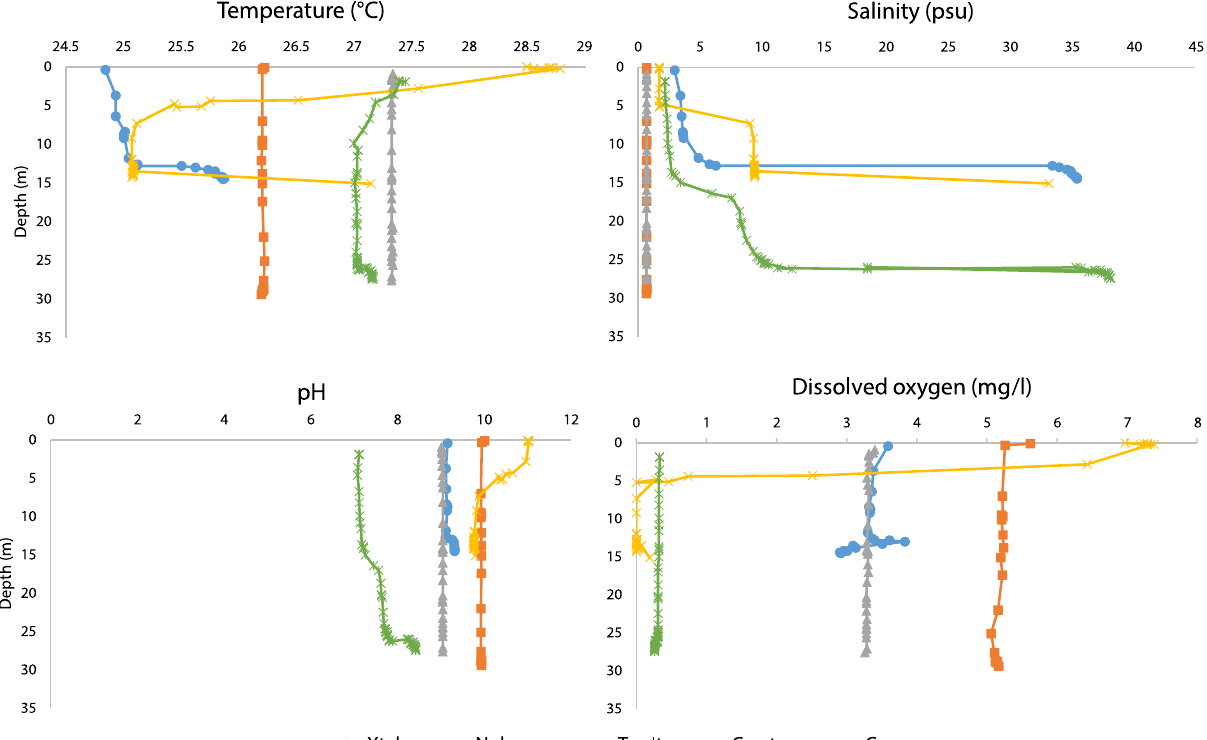
Figure 2. Vertical profile of physical and chemical hydrological parameters (Temperature, Salinity, pH and Dissolved Oxygen) of Cave Systems, Xtabay (blue), Nohmozon (orange), Tza Itza (grey), Crustacea (yellow) and Cervera (green). Data obtained using a Hydrolab